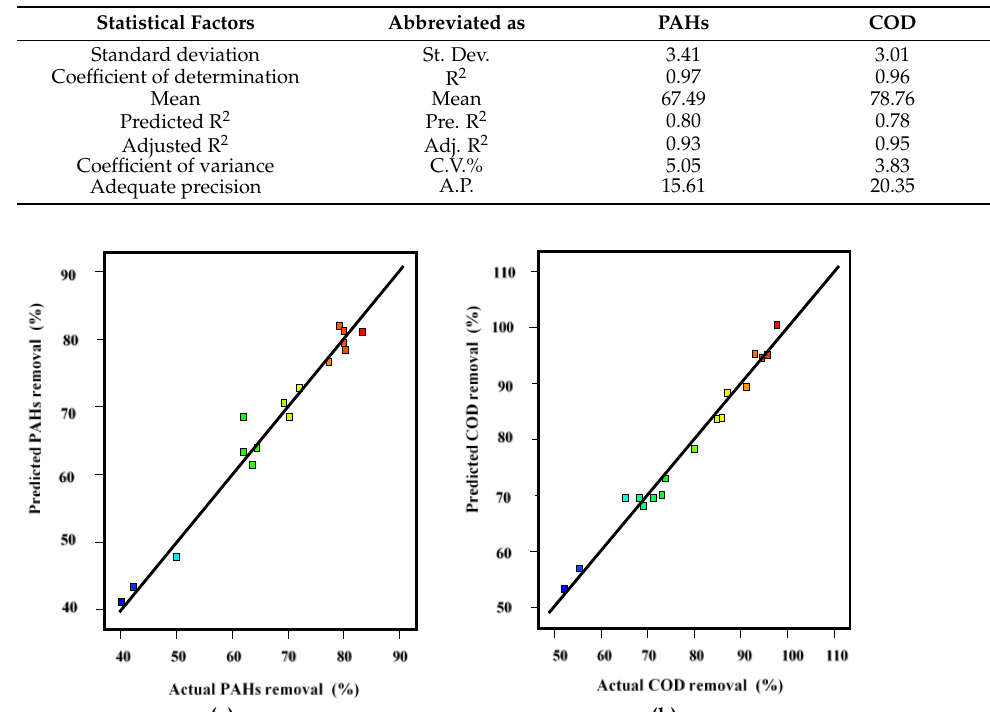
Figure 2. Predicated and experimental removal: ( a ) PAH removal and ( b ) COD removal.